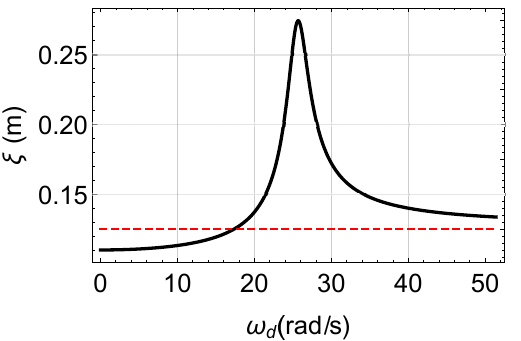
Figure 3. The relationship between the magnitude of the steady state response and the desired rotational velocity of the spinner.